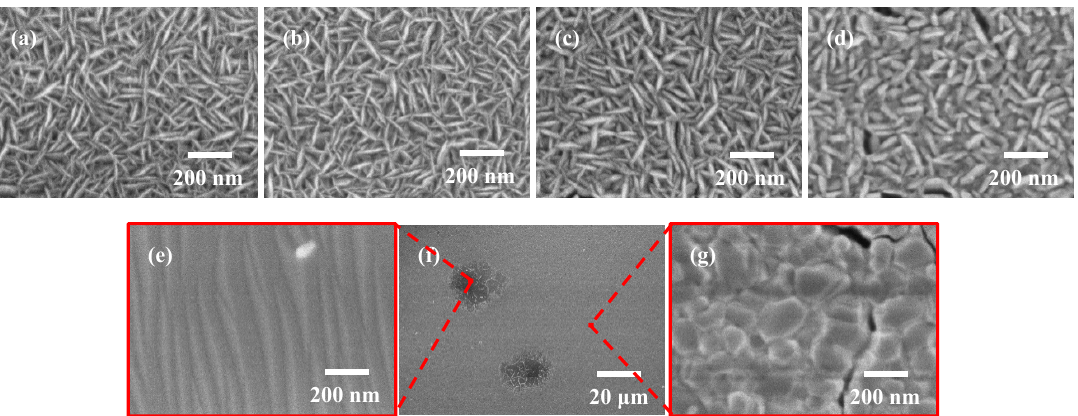
Figure 5. FE-SEM images of as-deposited TiO 2 films ( a ) and TiO 2 films calcined at different temperatures (( b ) 600 °C; ( c ) 800 °C; ( d ) 1000 °C; ( e – g ) 1100 °C).